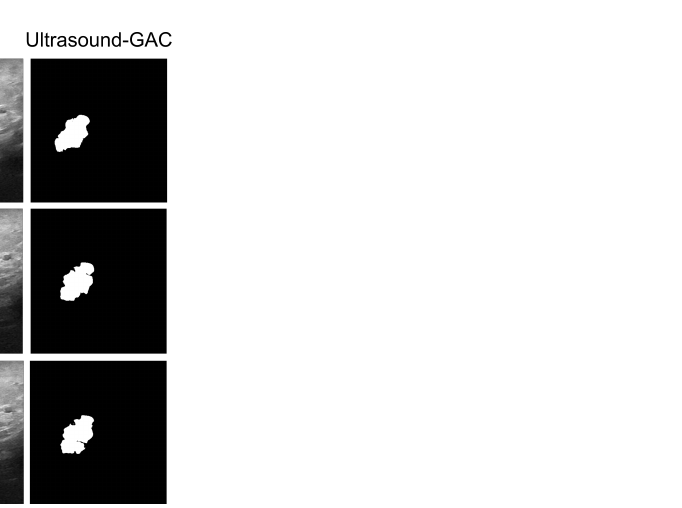
Figure 4. (Middle column) Three exemplary original ultrasonic images of the same tumor, which are marked as “malignant 3–9” in BUSI. (First column) the corresponding three different tracings provided by BUSI for the same tumor. As can be observed, the three tracings differ substantially in shape and geometry. (Last column). Contrary to that, the corresponding MorphGAC segmented masks yielded more consistent tracings, which appear to better match the lesion shapes in the ultrasound images.